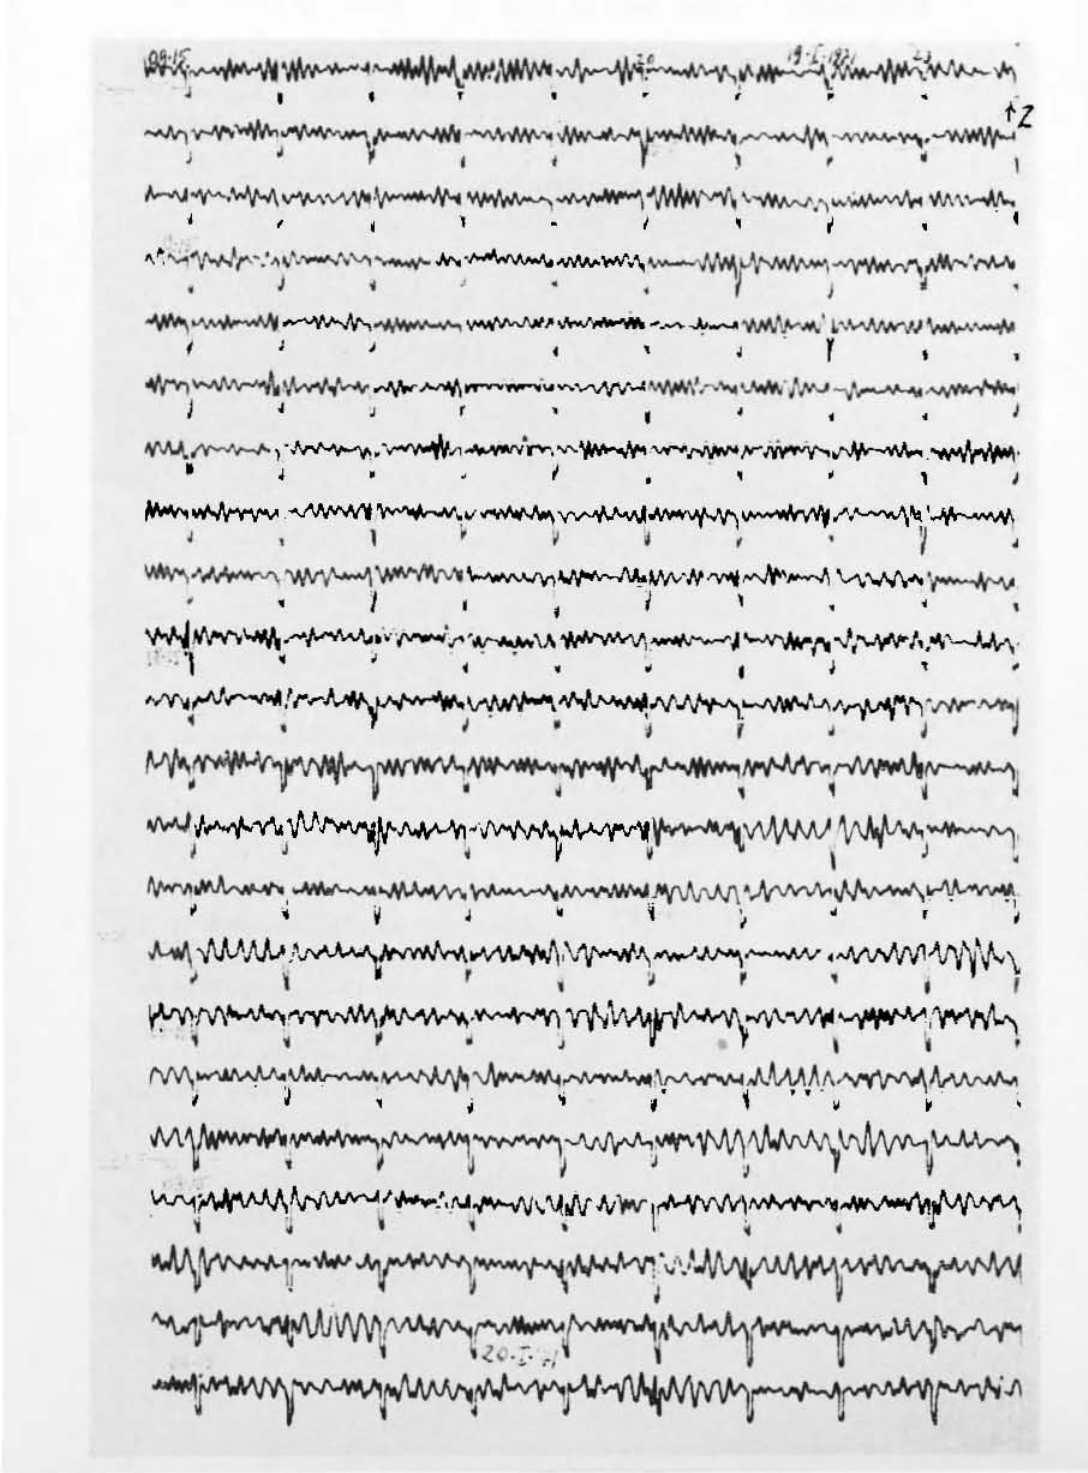
Fig. 33 - Il 19.1. 1971 un'ampia zona ,li b:l.l>Sa pro;;sione al:isl'e Ilei pres6i (Iolle coste l;.Can· (linave, provocando la creazione di micrusismi, con periodi dell'urt.lino di 5',5 ca-I'arat. t-eristici della zona